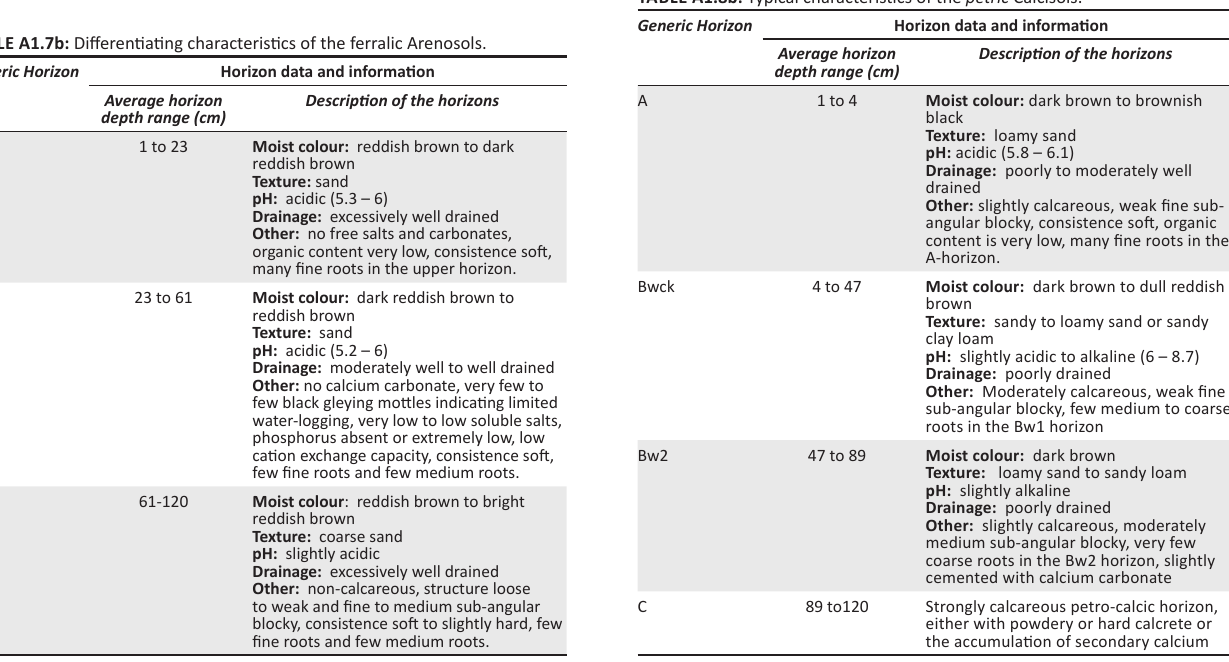
TABLE A1.8b: Typical characteristics of the petric